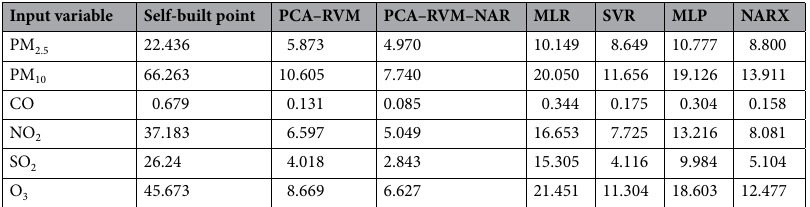
Table 3. The RMSE of self-built point and various air quality prediction models, in which national control point is used as comparison object.